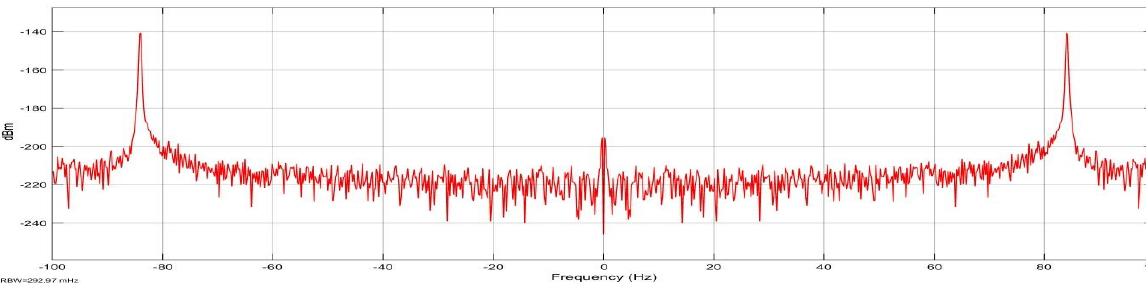
Fig. 7: Frequency Response of the Lateral Acceleration when Vehicle speed =10m/s and Conicity of Wheel = 0.15